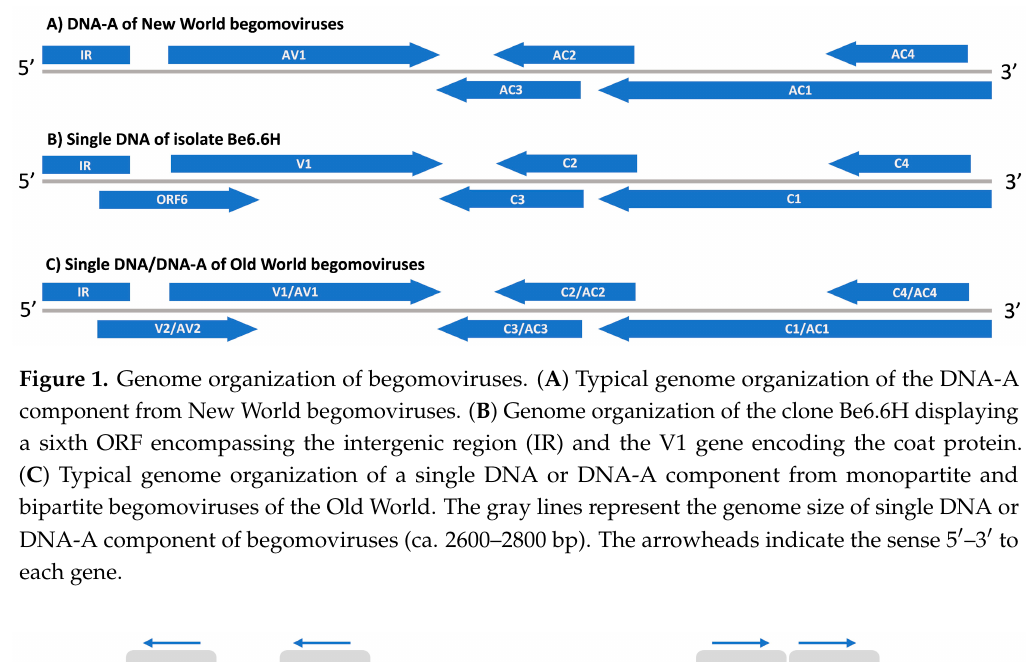
Figure 1. Genome organization of begomoviruses. (A) Typical genome organization of the DNA-A component from New World begomoviruses. (B) Genome organization of the clone Be6.6H displaying a sixth ORF encompassing the intergenic region (IR) and the V1 gene encoding the coat protein. (C) Typical genome organization of a single DNA or DNA-A component from monopartite and bipartite begomoviruses of the Old World. The gray lines represent the genome size of single DNA or DNA-A component of begomoviruses (ca. 2600–2800 bp). The arrowheads indicate the sense 5 ˊ –3 ˊ to each gene.